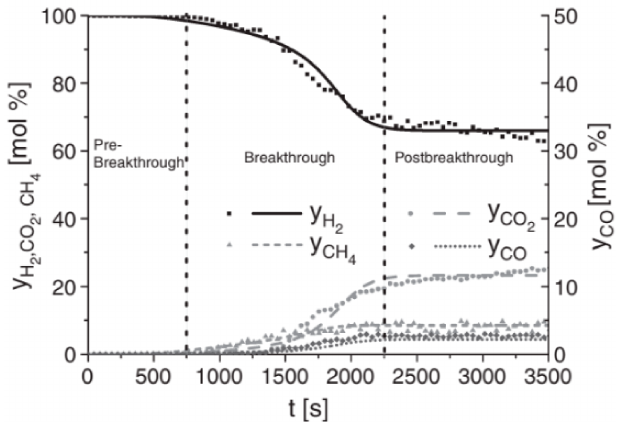
Figure 11. Example of product distribution as a function of time in the outlet of an SER (steam reforming of ethanol for hydrogen production). Reprinted with permission from Ref. [162]. Copyright 2021